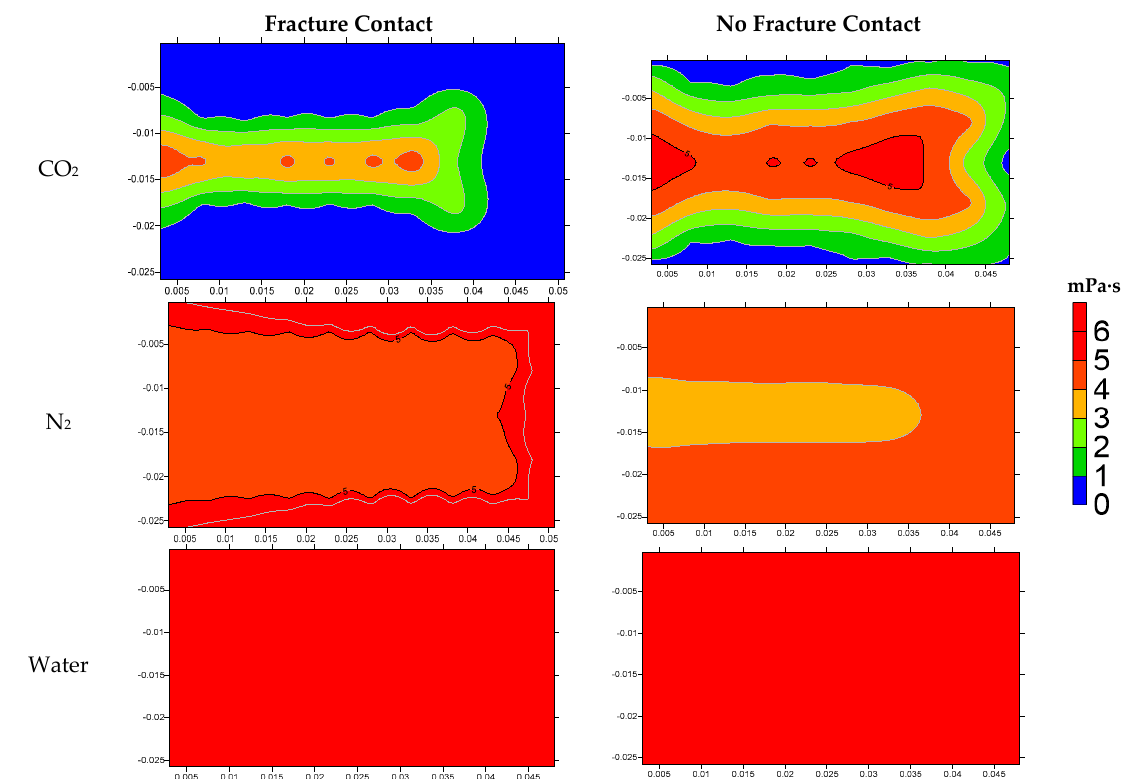
Figure 12. Oil viscosity of different fluids in Case-4 in soaking process (ij profile).